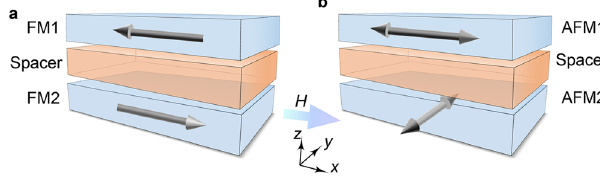
Fig. 1 Two types of interlayer coupling in magnets. a Illustration of the antiparallel interlayer coupling in the top and bottom ferromagnetic layers (FM1 and FM2) b Illustration of the orthogonal interlayer coupling between antiferromagnets (AFM1 and AFM2) found